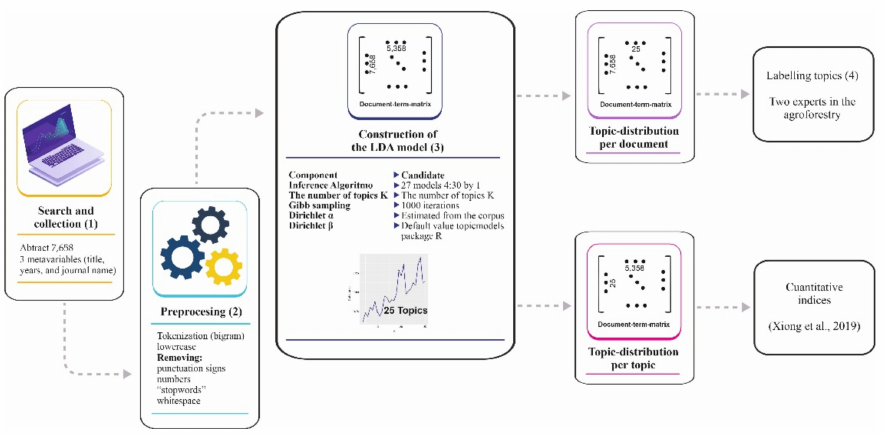
Figure 1. Scheme of the methodological process used in the procedure for the identification of topics through Latent Dirichlet